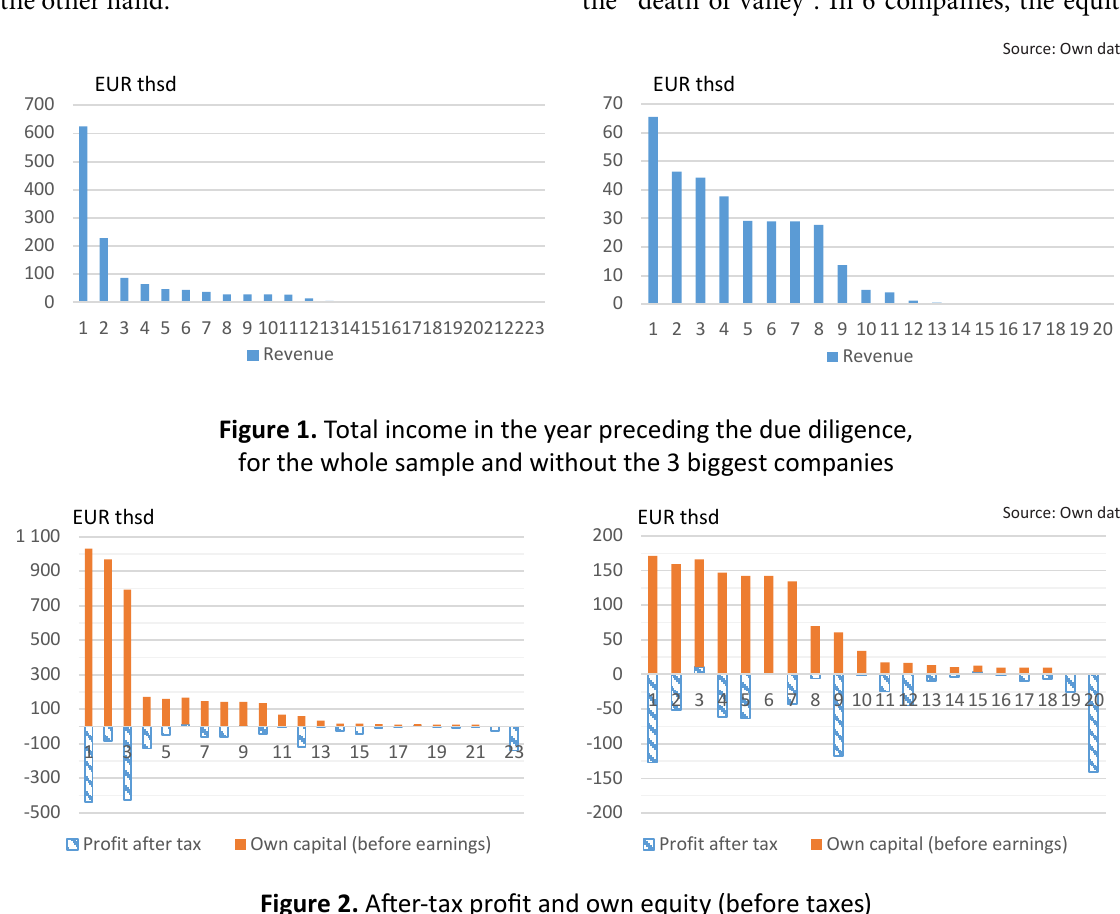
Figure 2. After-tax profit and own equity (before taxes)